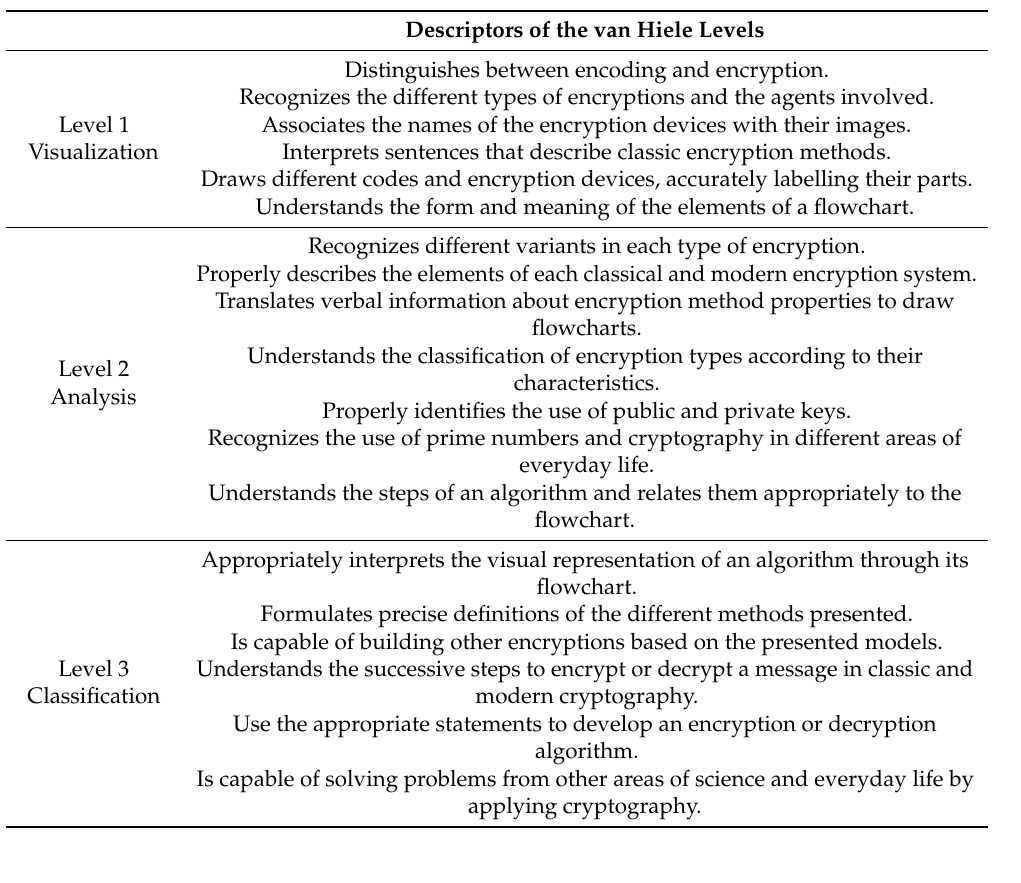
Table 2. Descriptors of the van Hiele levels I, II and III for